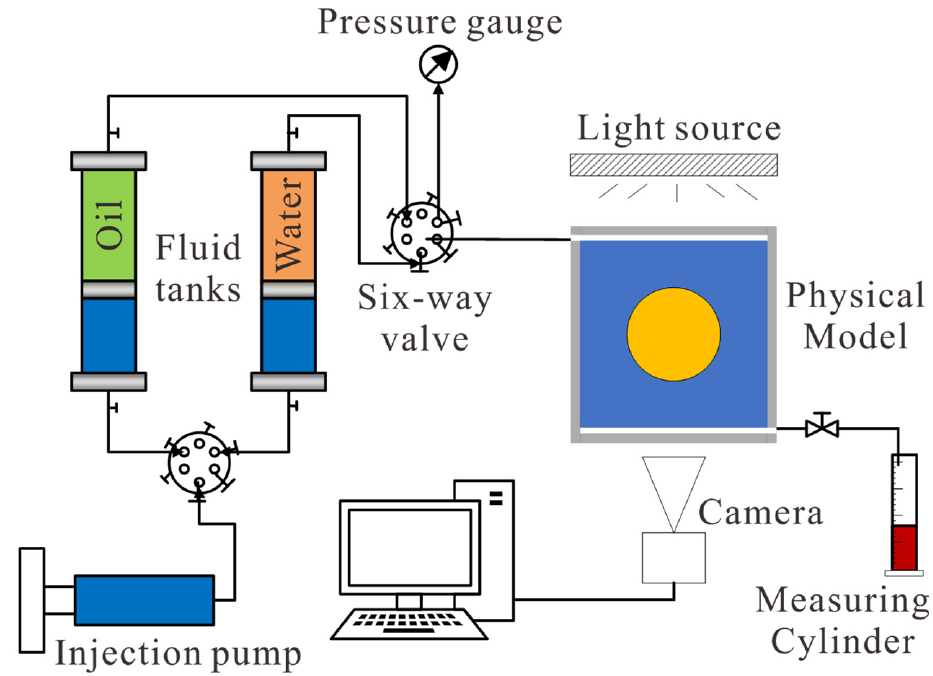
Figure 3. Schematic of the experiment setup.